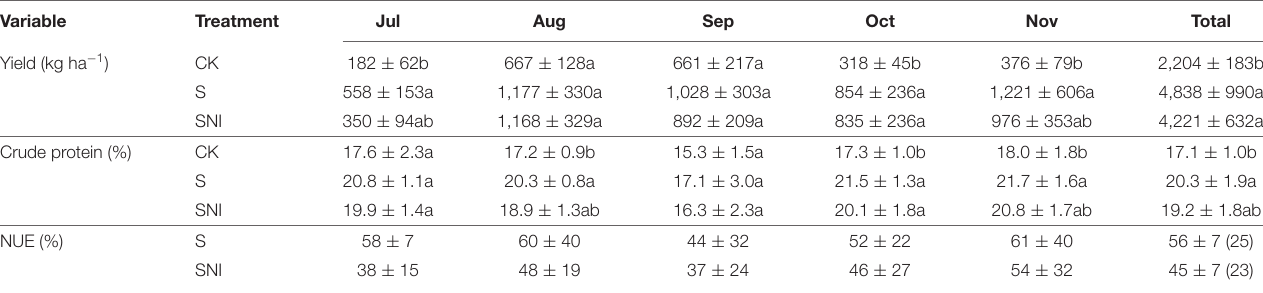
TABLE 4 | Yield (dry matter) and crude protein mean of Cynodon nlemfuensis from control (CK), dairy farm effluent (S), and dairy farm effluent plus nitrapyrin (SNI) as well as the nitrogen use efficiency (NUE) of a field trial conducted in 2017 on a permanent pasture in the Alfredo Volio Mata Experimental Station, Costa Rica. Variable